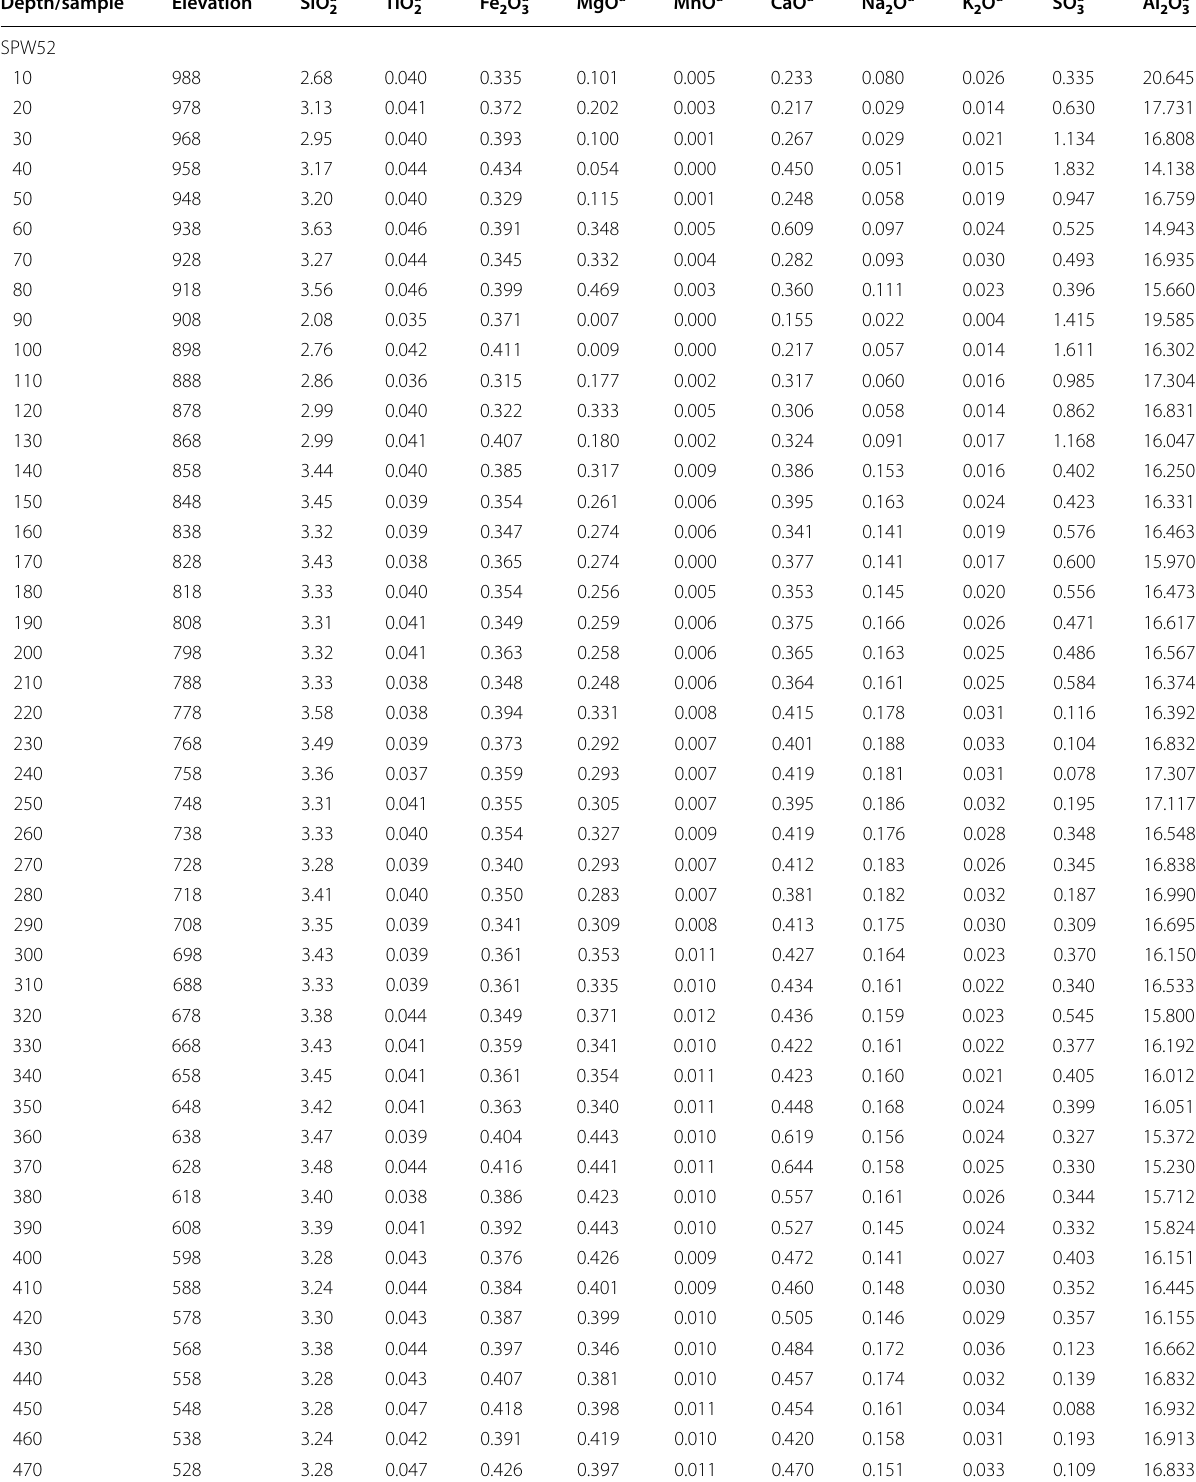
Table 3 Bulk rock chemistry of cutting samples from SPW52 and products of the 2015 eruption